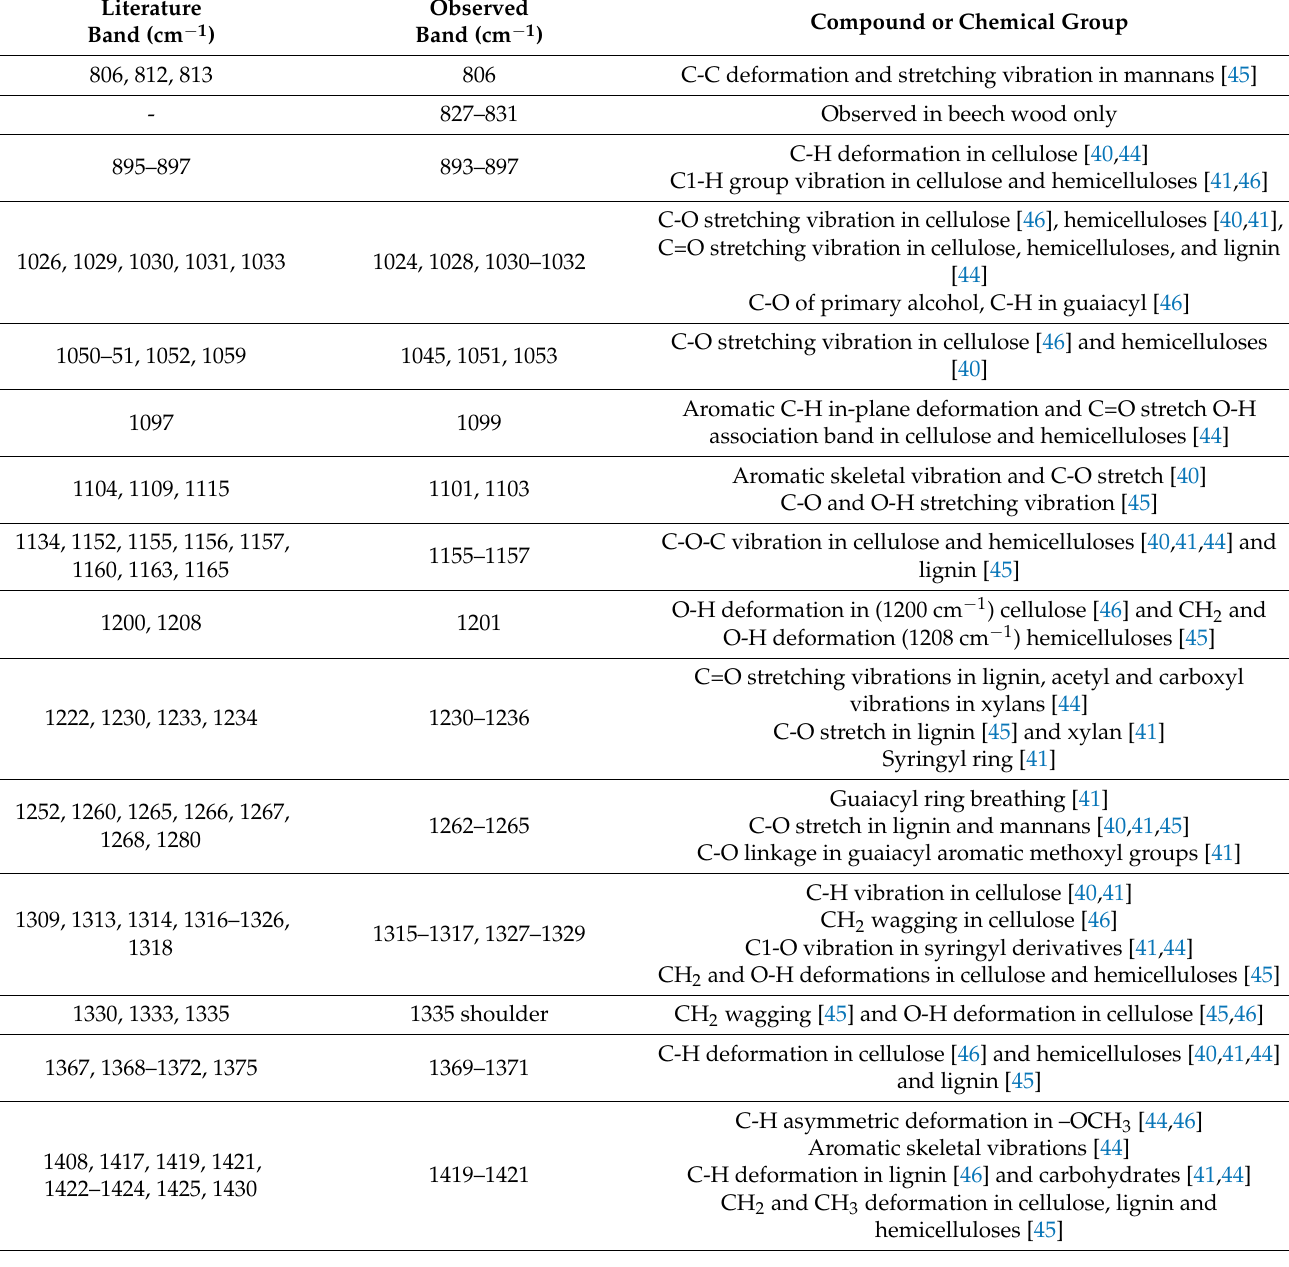
Table 2. Assignment of IR characteristic bands for wood degradation after Cogulet [40], Bari [44], Ozgenc [41], Dirckx [45], and Pandey